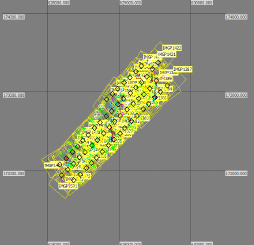
Figure 4. Photogrammetric Block for 60 UAV Images